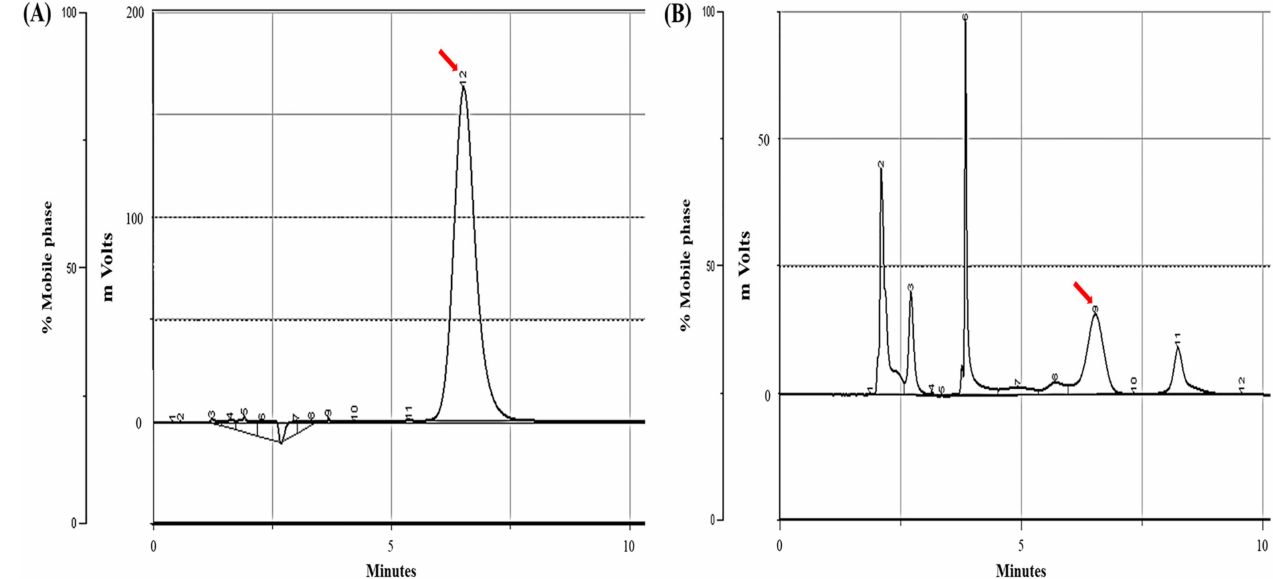
Figure 3. High-performance liquid chromatography (HPLC) chromatograms of PTA. ( A ) PTA (200 µ g/mL) standard sample (arrow) and ( B ) BF sample